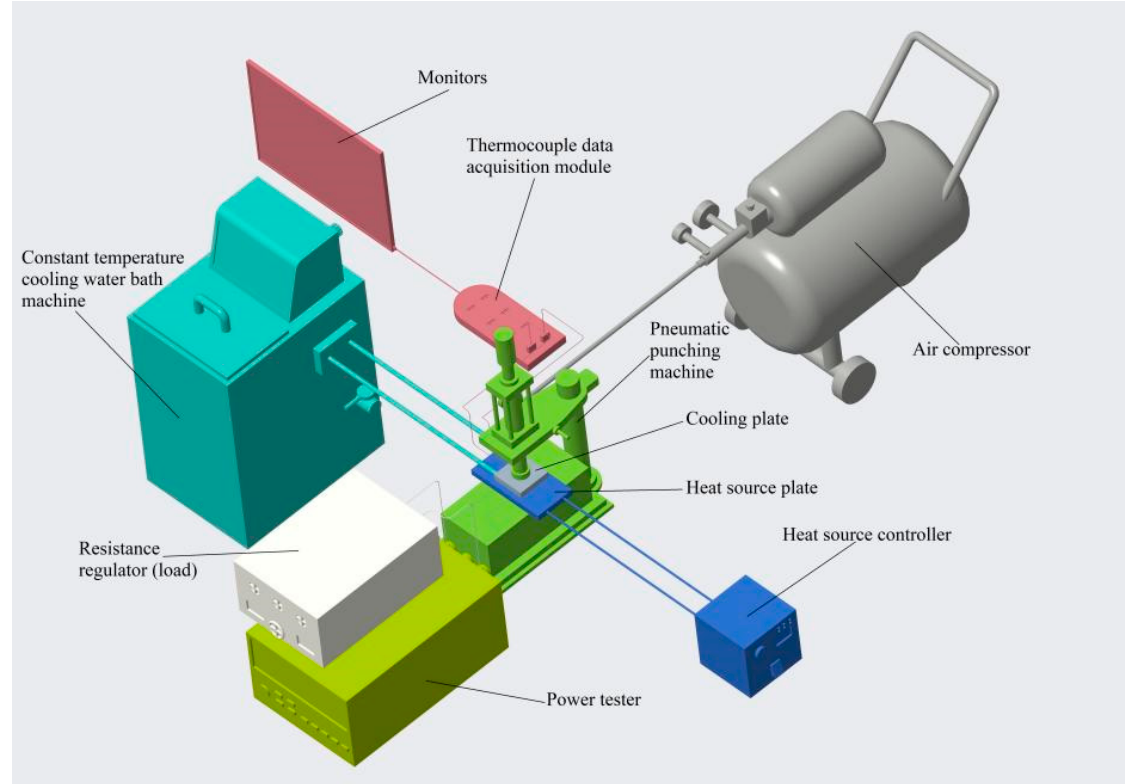
Figure 2. Experimental platform assembly structure diagram.